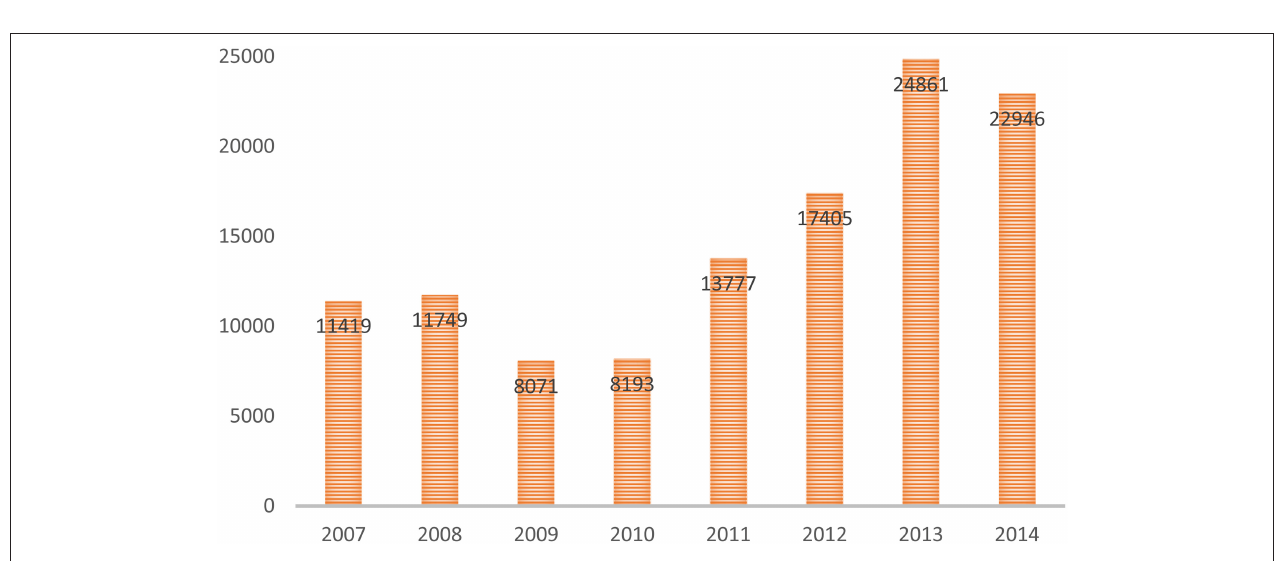
FIGURE 2 | Yearly Indoor Radon Concentration records in